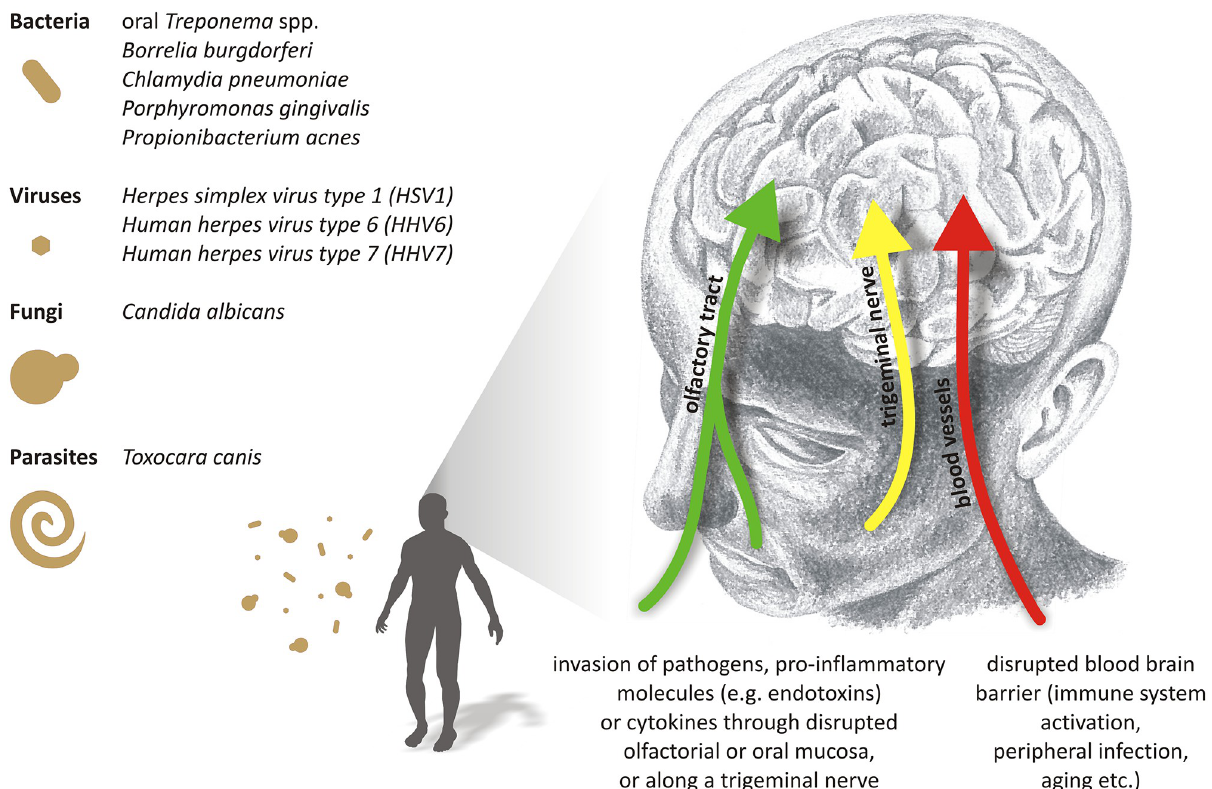
Fig 2. Pathogens possibly associated with AD pathology and suggested ways of their entry into the brain. On the left, the most important pathogens associated with AD discussed in this review. Pathogens inhabiting nasal and oral cavity can migrate through disrupted mucosa and then along the olfactory nerve (e.g., Chlamydia pneumoniae ; left green arrow) or the trigeminal nerve (e.g., periodontal Treponema species and Herpes simplex virus type 1 ; middle yellow arrow). Microbes from both oronasal area and the periphery can enter the bloodstream during transient bacteremias or candidemias (e.g., Porphyromonas gingivalis , Candida albicans ) and then attack the brain through disrupted BBB (right red arrow). Parasites like Toxocara canis also enter the CNS from the blood vessels. AD, Alzheimer’s disease; BBB, blood–brain barrier; CNS, central nervous